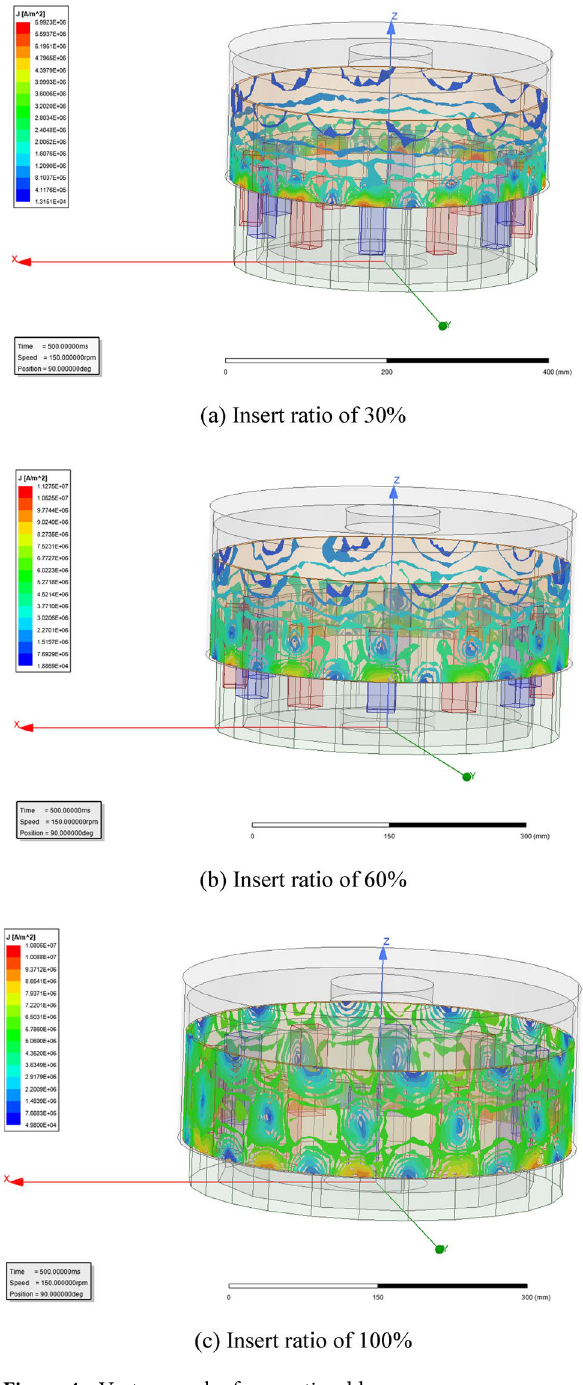
Figure 4. Vector-graph of magnetic